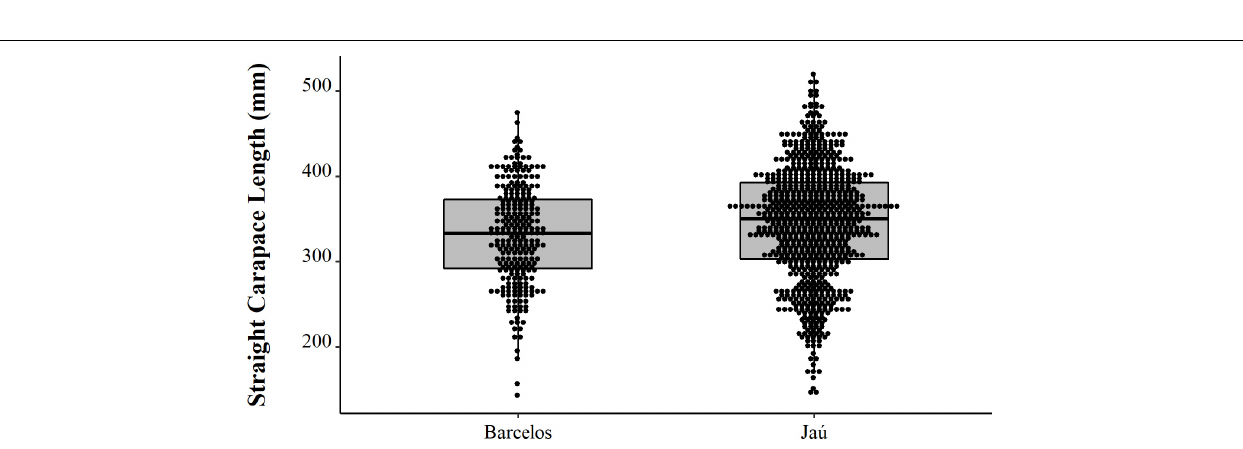
FIGURE 5 | Spatial distribution (points) and descriptive statistics (boxplot) of body size (SCL, mm) of Big-headed ( Peltocephalus dumerilianus ) intended for commercialization, from the Jaú River and the city of Barcelos, Rio Negro, Amazonas between 1997 and 2002.